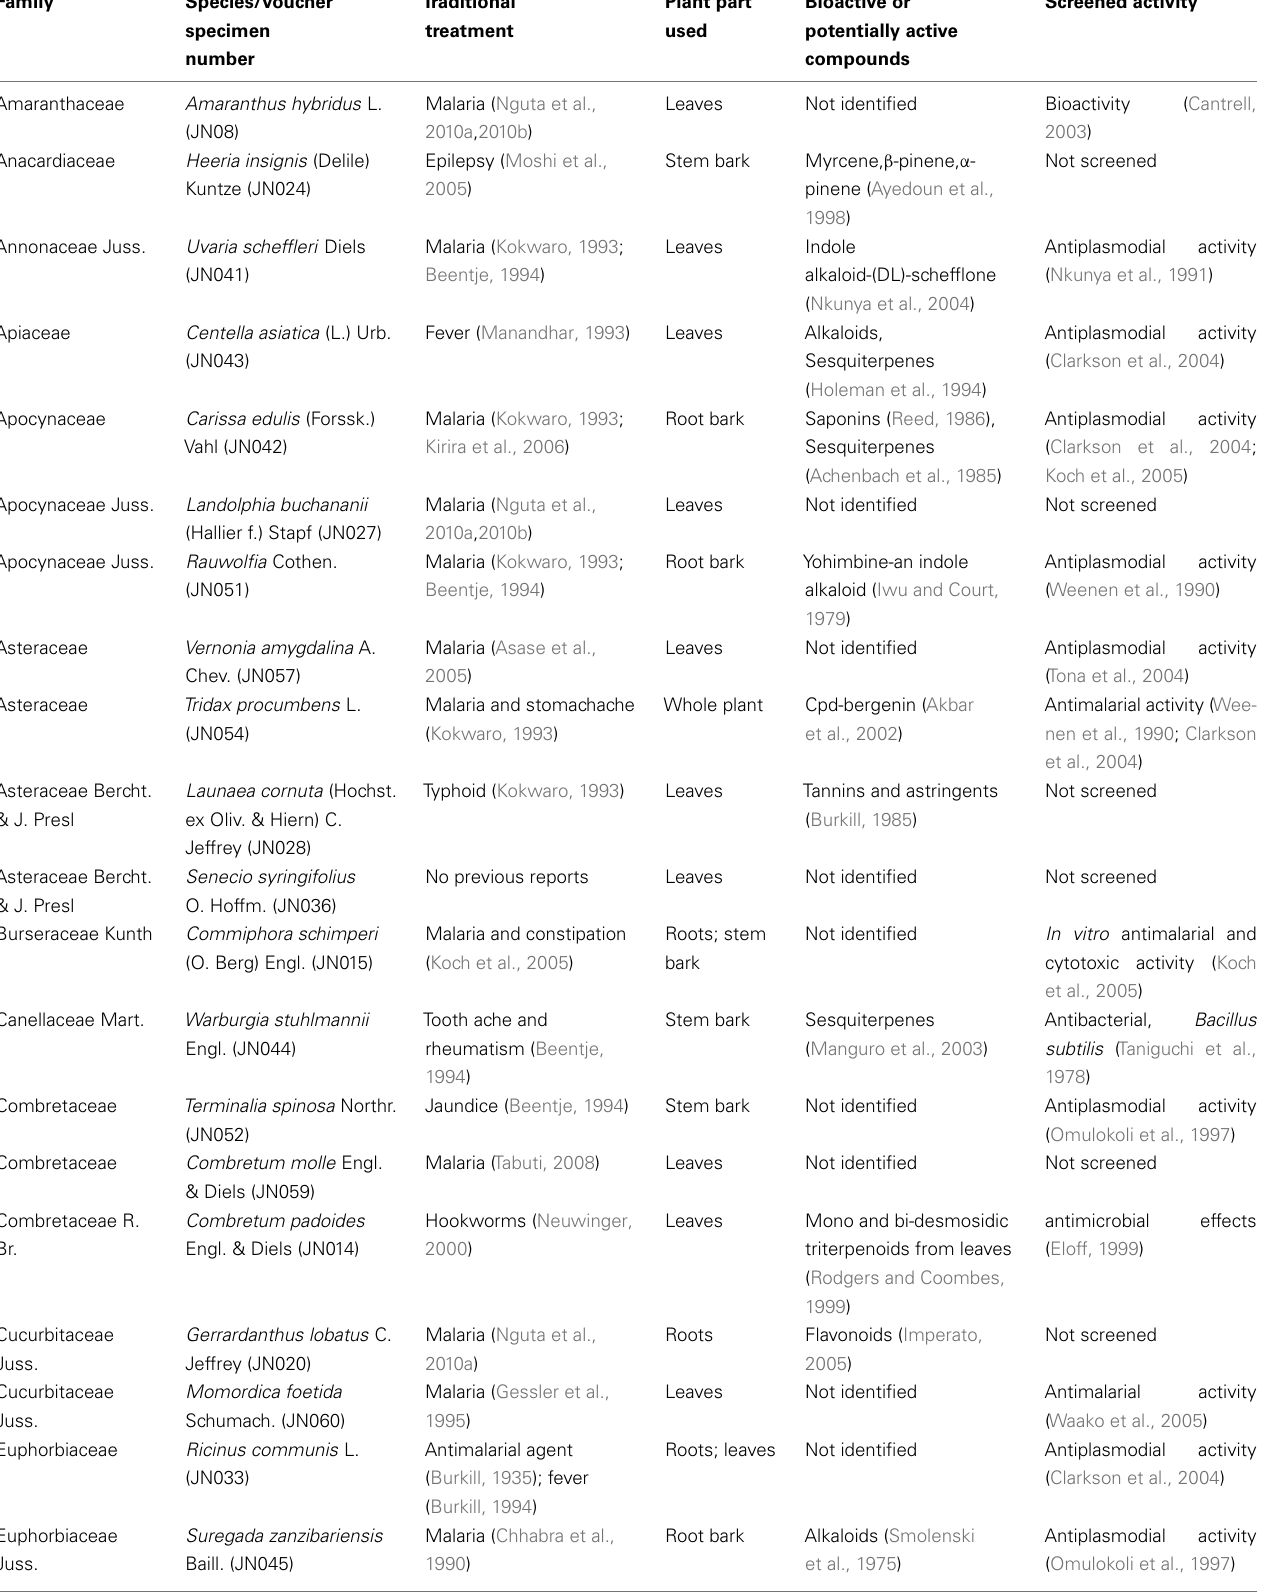
Table 4 | Plants used by the Digo community to treat malaria and the published evidence of their activities and/or other uses.